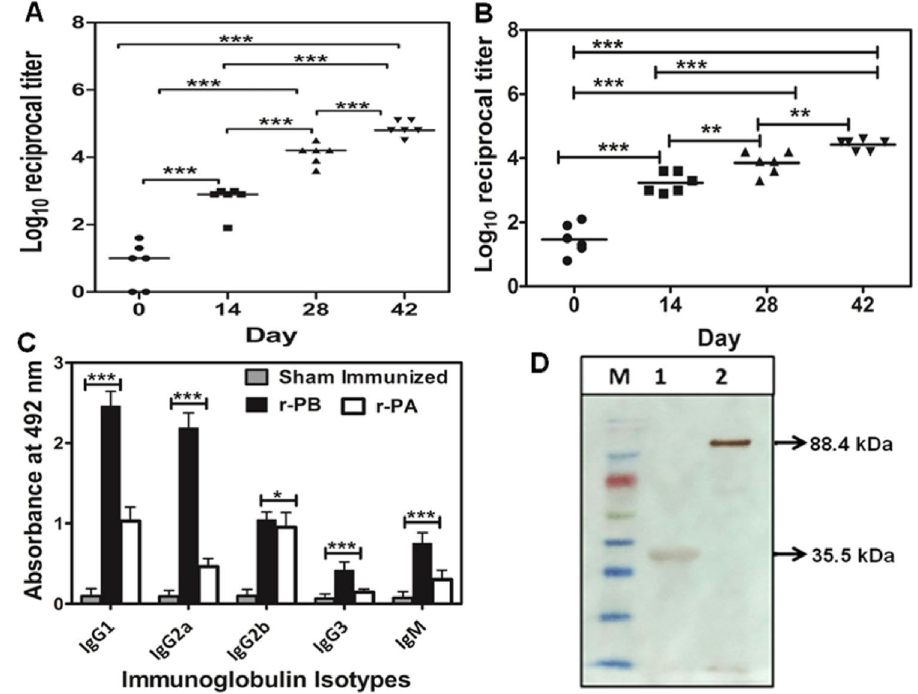
Figure 2. Characterization of r-PB antibody. ( A ) Anti r-PB and ( B ) anti-r-PA specific end point titres of sera collected on 0 th , 14 th , 28 th and 42 nd day of immunization schedule from 6 randomly selected r-PB or r-PA immunized mice respectively were determined by indirect ELISA and plotted. ( C ) Determination of r-PB and anti-r-PA specific antibody subclasses on the 42 nd day (1:1000 th dilution) sera. The experiments were performed in triplicates and the data are represented in mean ± S.D. ( D ) Western blot analysis to show the reactivity of anti-r-PB sera with BclA (Lane 1) extracted from spores and PA from B. anthracis culture supernatant (Lane